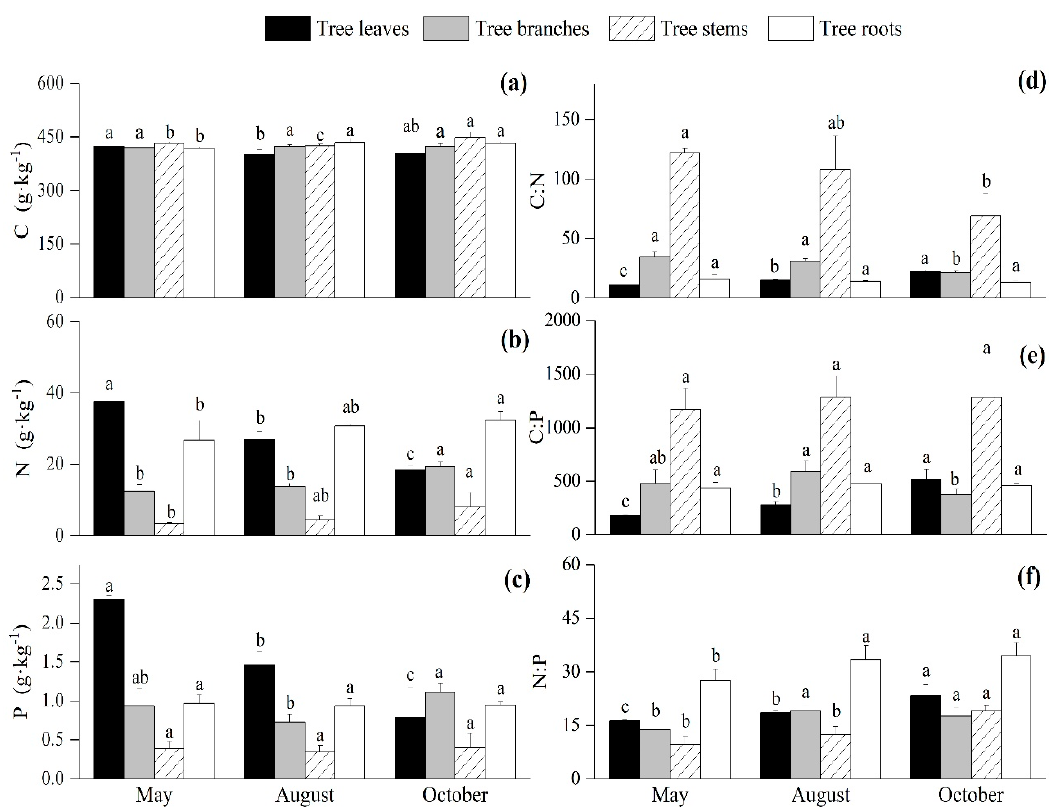
Figure 2. Seasonal variations of C, N, and P contents and ratios in arbor layer. ( a ) describes the C content of the tree layer; ( b ) describes the N content of the tree layer; ( c ) describes the P content of the tree layer; ( d ) describes the C:N ratio of the tree layer; ( e ) describes the C:P ratio of the tree layer; ( f ) describes the N:P ratio of the tree layer. Different small letters over the bars represent the significant differences among the different growing seasons at P < 0.05, the same as below.